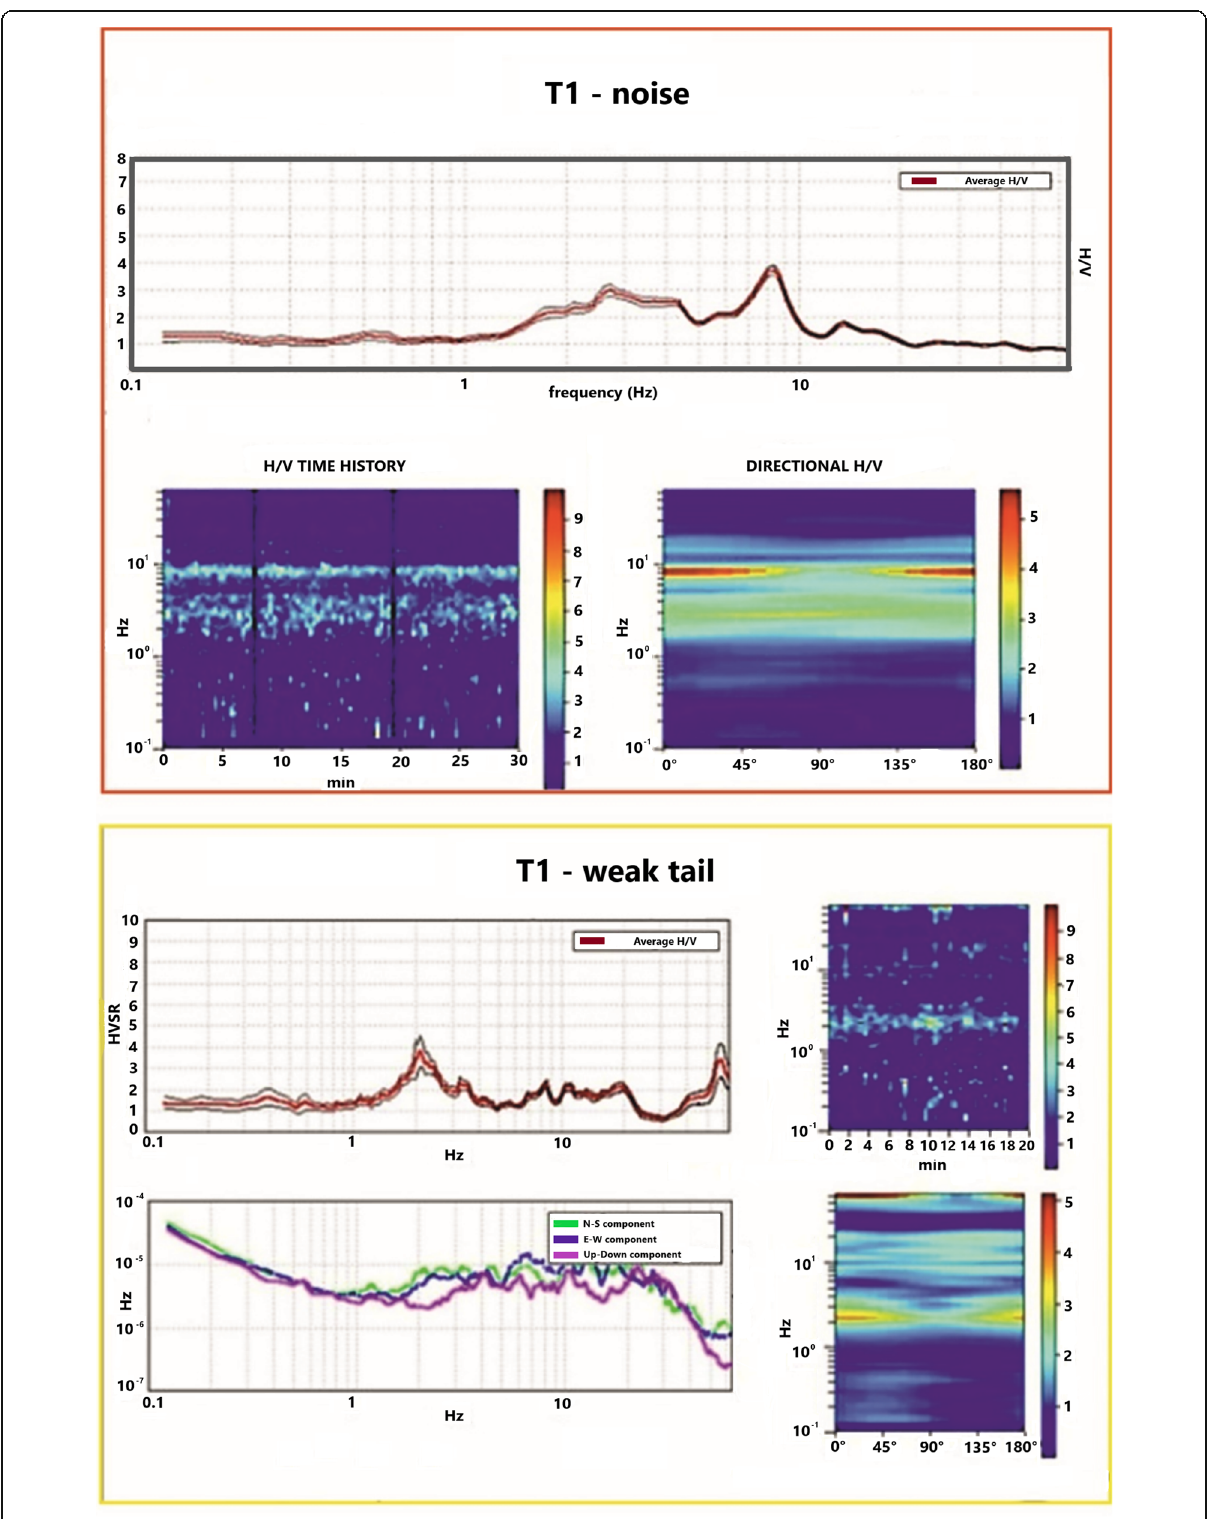
Fig. 10 HVSR function measured at the T1 site, at Tussillo site (see Fig. 8) from: a the noise measurements; b the weak motion tail of a seismic event recorded on 7 July 2009, at 10:15 local